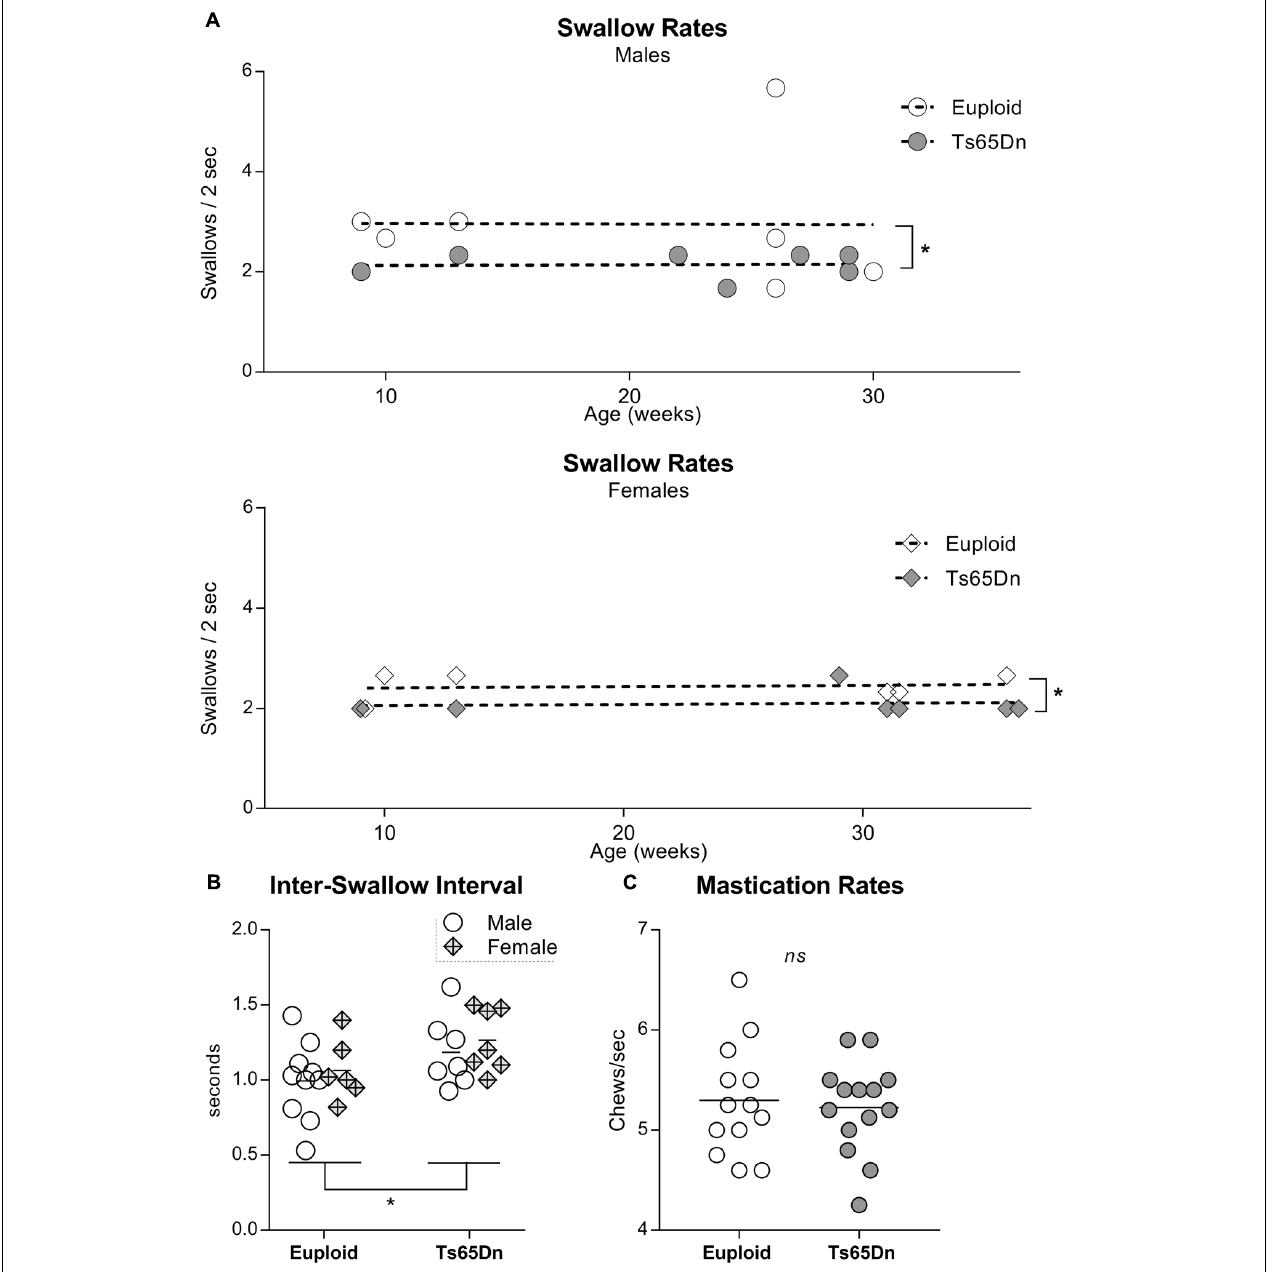
FIGURE 2 | Videofluoroscopic swallow studies analysis of male and female Ts65Dn mice across an adult age range. Each symbol indicates the average of 3–5 separate iterations of the measure for a single mouse. (A) Swallow rates for each sex, distributed across an adult age range. (B) ISI measurements from mice in panel (A) . (C) Mastication rates assessed from analysis of high-speed video footage of adult male mice eating hard food pellets. ∗ p ≤